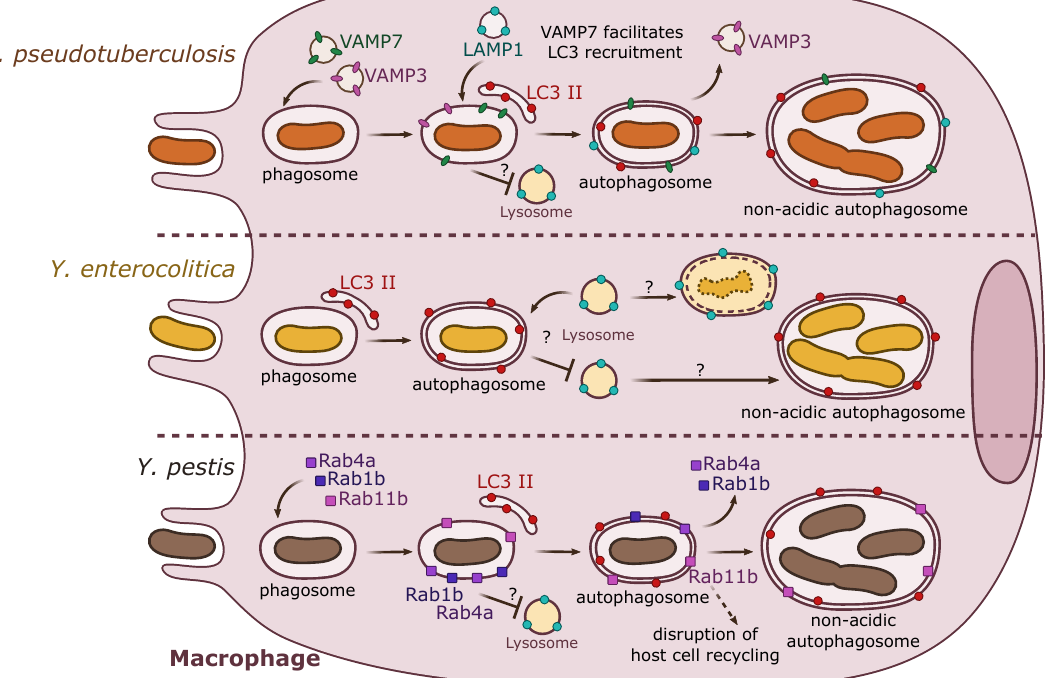
Figure 1. Summary results from independent studies of autophagy induction by Y. pseudotuberculosis, Y. enterocolitica , and Y. pestis in macrophages. Y. pseudotuberculosis (top) recruits VAMP3 and VAMP7 to